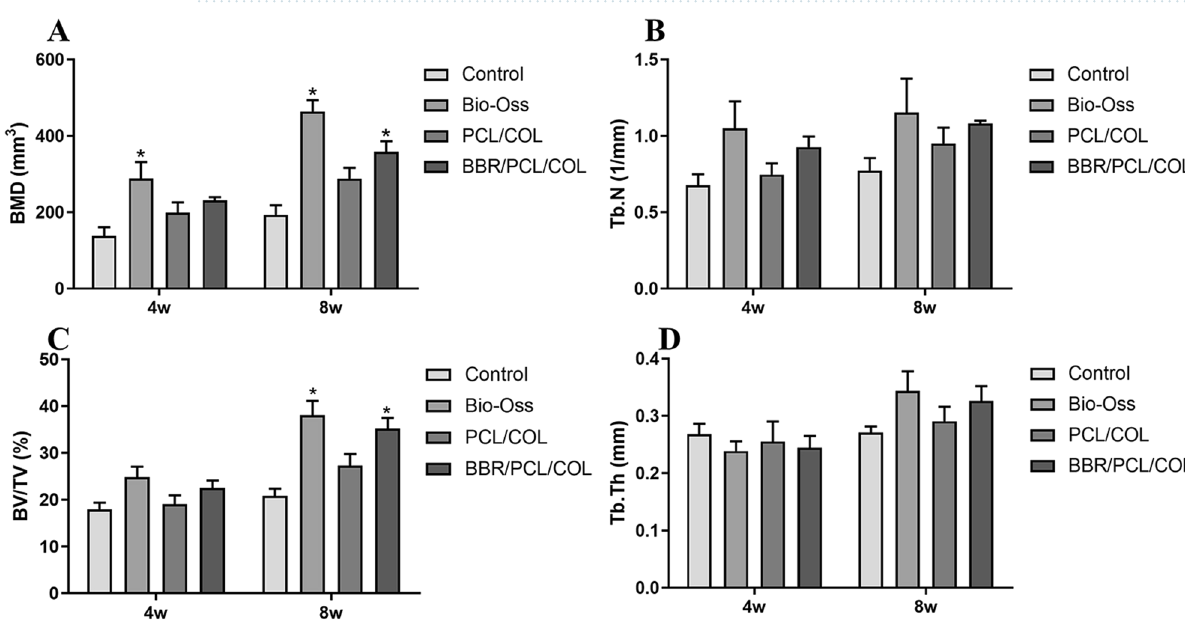
Figure 6. Quantitative analysis of bone related parameters at 4 weeks and 8 weeks after implantation. “*” means the comparison between the control group and the experimental group, P <